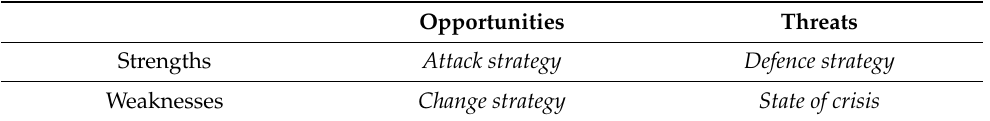
Table 2. Pure strategies for the different crossovers between the Strengths/Weaknesses and the